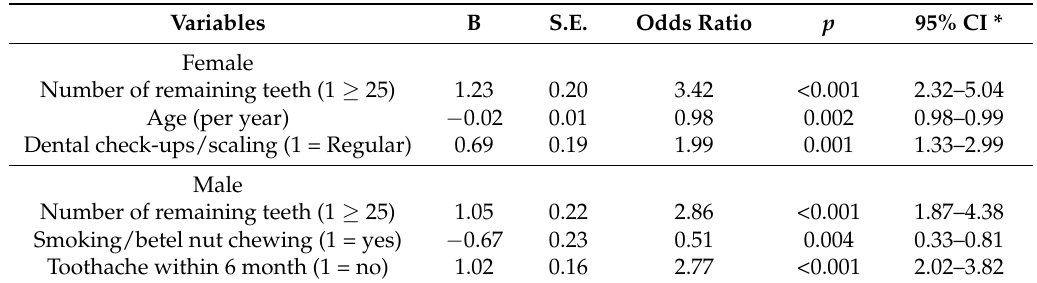
Table 4. Factors associated with perception good of oral health status stratified by